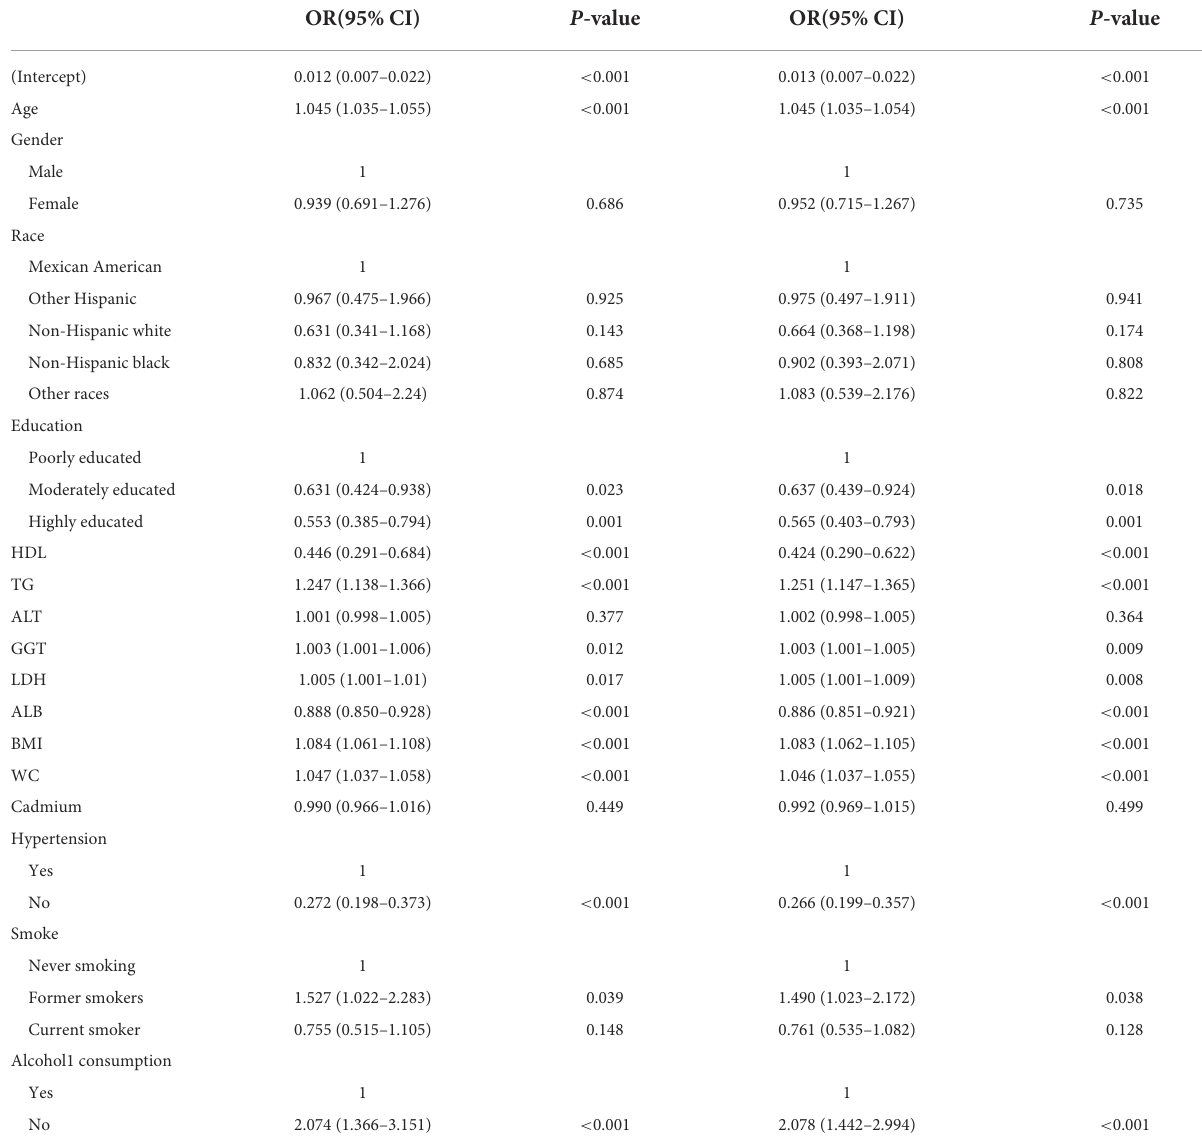
TABLE 3 Univariate logistic regression analysis for diabetes in the high cadmium exposure group Variable Before multiple